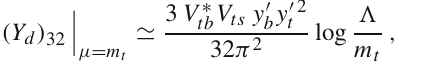
,withquarkflavour lq